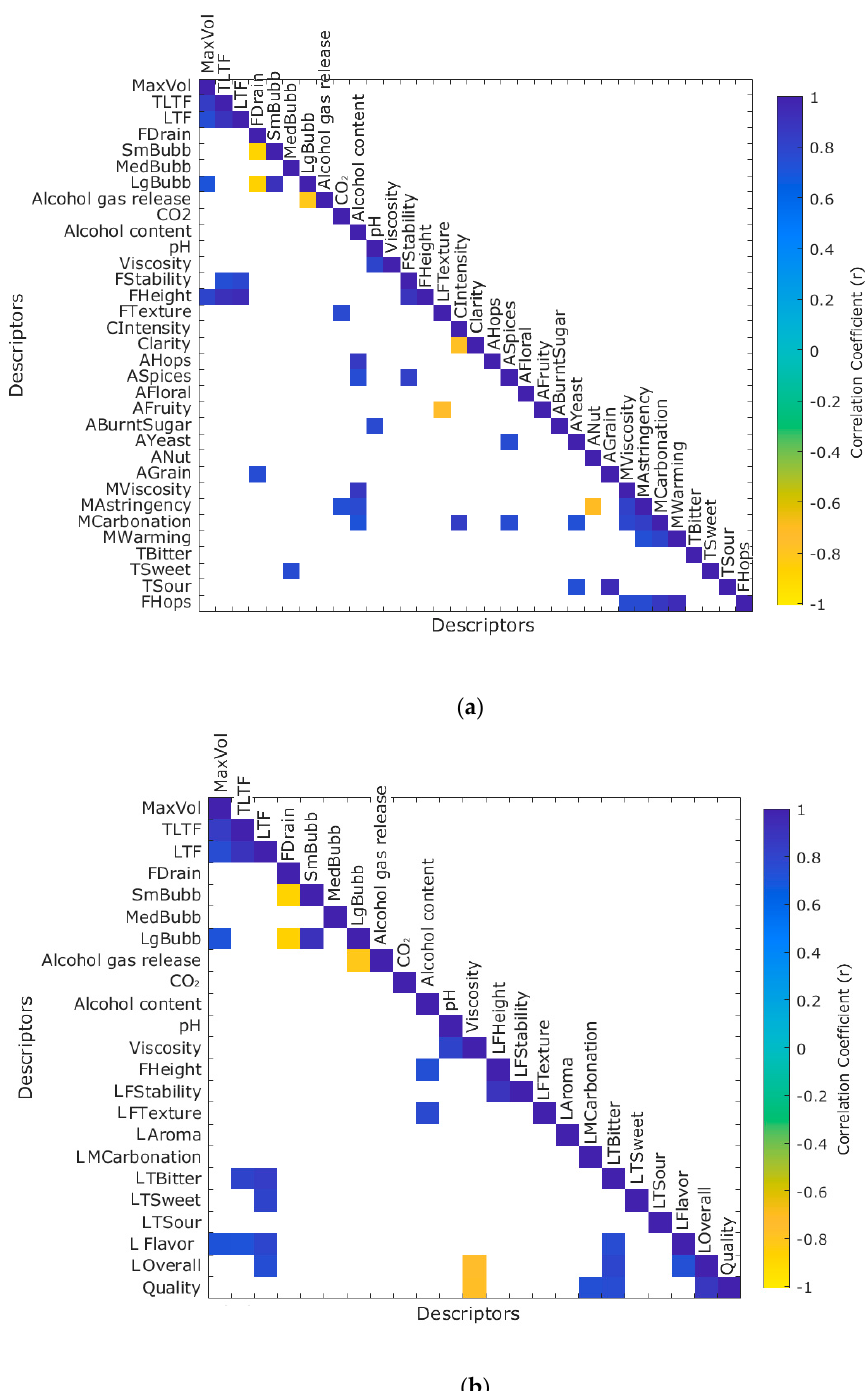
Figure 4. Matrices showing the correlations between the physicochemical parameters and ( a ) the intensity of sensory descriptors assessed with the trained panel and ( b ) the liking of sensory attributes from the consumers test.